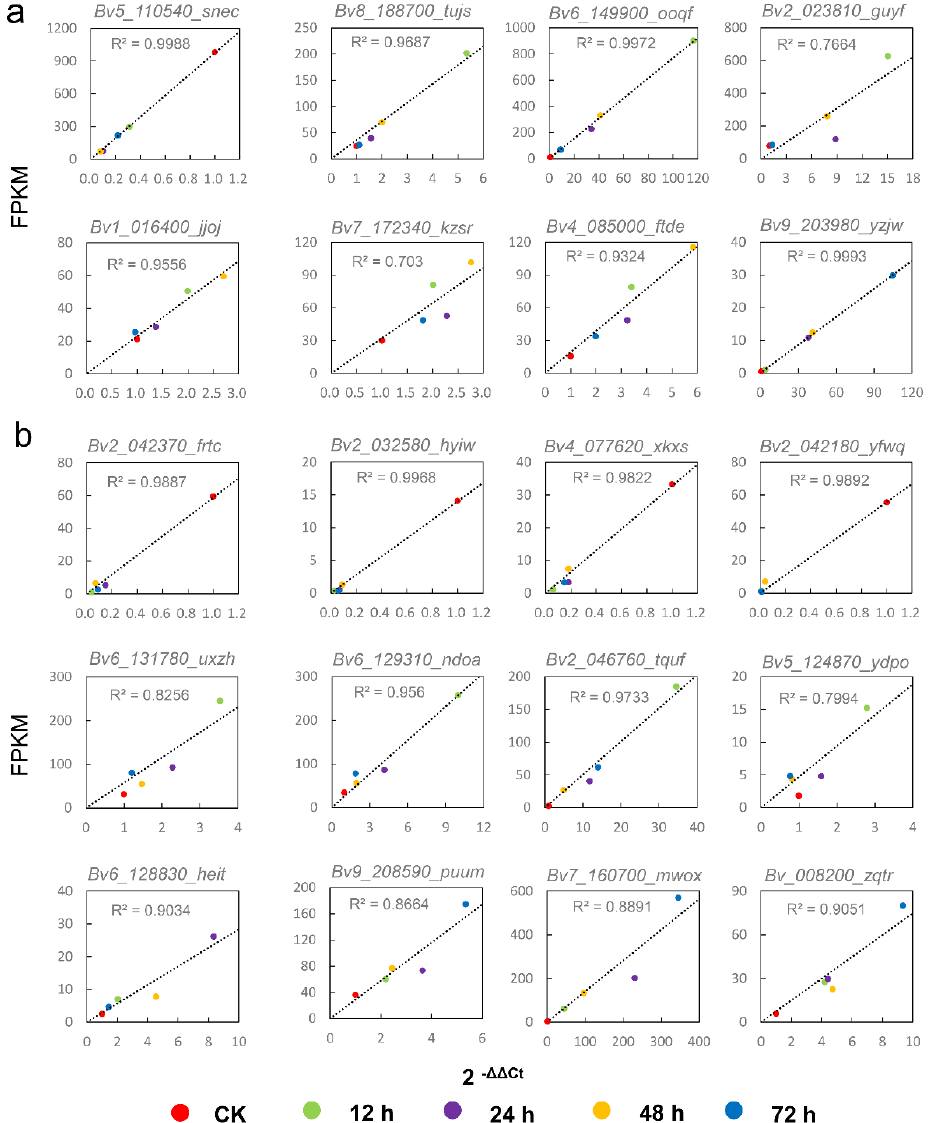
Figure 7. Comparison between qRT-PCR and deep sequencing of hub genes under salt stress. ( a ) leaf. ( b ) root. Triplicate biological replicates were performed. The X -axis represents qRT-PCR results (relative quantity calculated by 2 −ΔΔCT ), and the Y − axis represents RNA − SEQ results (FPKM); ** ( p < 0.05) and * ( p < 0.1) represents significant differences.